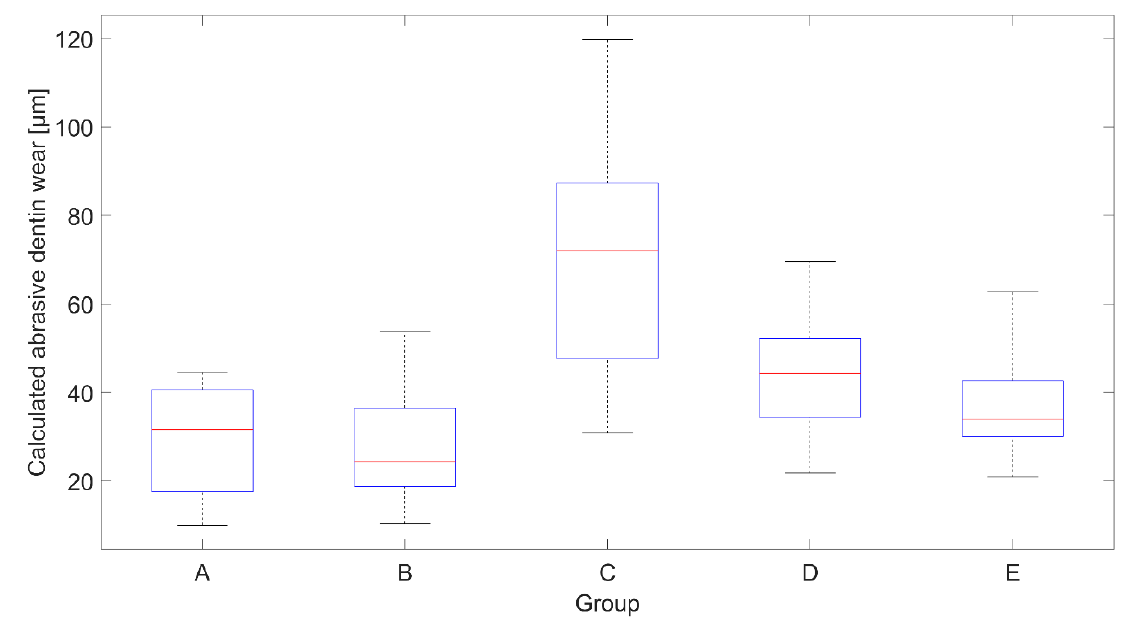
Figure 1. Calculated abrasive dentin wear after brushing. The red line indicates the median wear. The bottom and top edges of the box indicate the 25th and 75th percentiles, respectively, and the whiskers extend to the most extreme data points. Groups are A: deionized water, B: Sensodyne Pro Schmelz, C: Splat Blackwood, D: Curaprox Black is White, and E: Prokudent Black Brilliant. Table 2. RDA, mean abrasive wear and standard deviation (SD) for dentin and enamel (taken from previous work [17]).